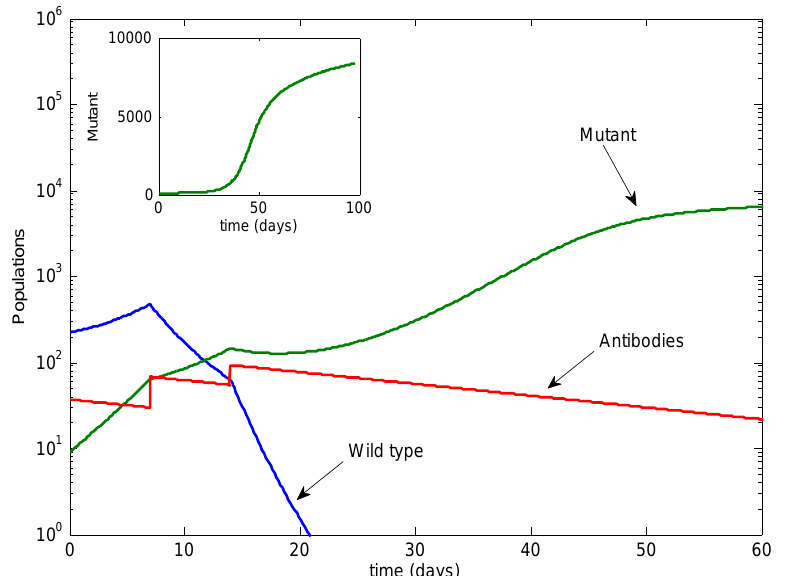
Figure 3. The standard case with three infusions. The wild type is cleared, but the mutant is not. Inset: the mutant on a linear